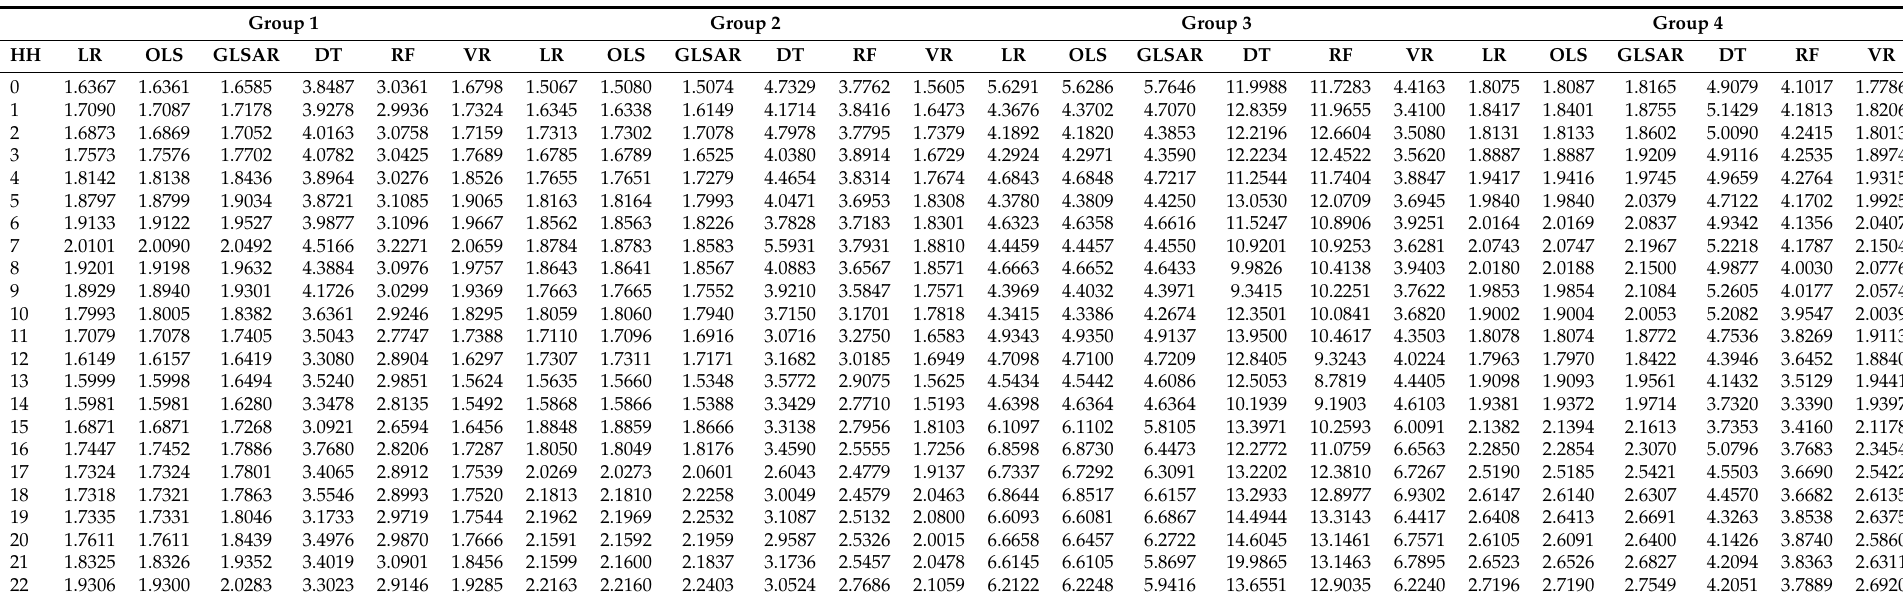
Table A7. Test MAPE values (in %) obtained by each half-hourly model in each